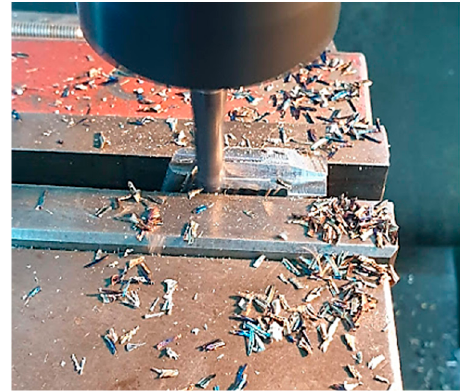
Figure 18. Milling the test tube.